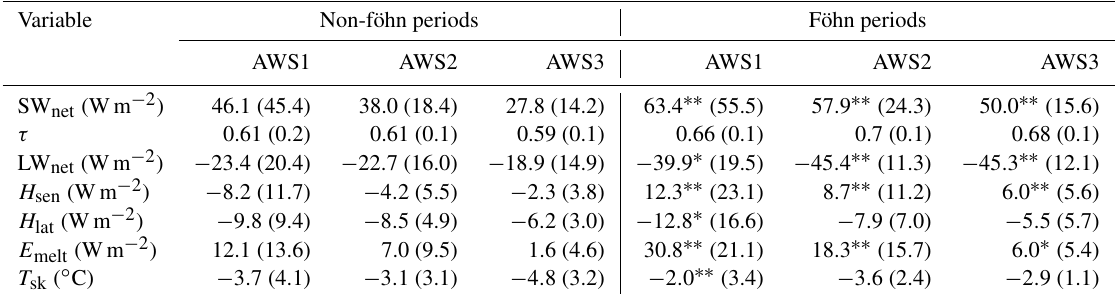
Table 5. Summer daily average values of SEB components and surface temperature during composites of föhn and non-föhn conditions at AWS1, AWS2 and AWS3. In brackets are the standard deviations for each field. Variable